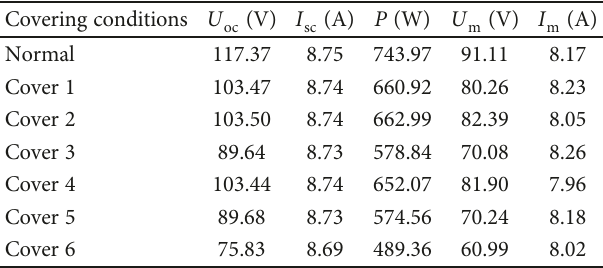
Table 4: Distribution of electric parameters under cover